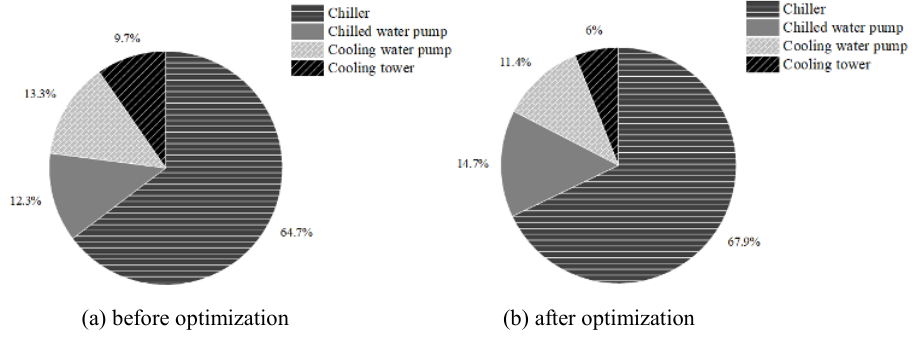
Fig. 7 . Comparison of power consumption ratio before and after optimization.